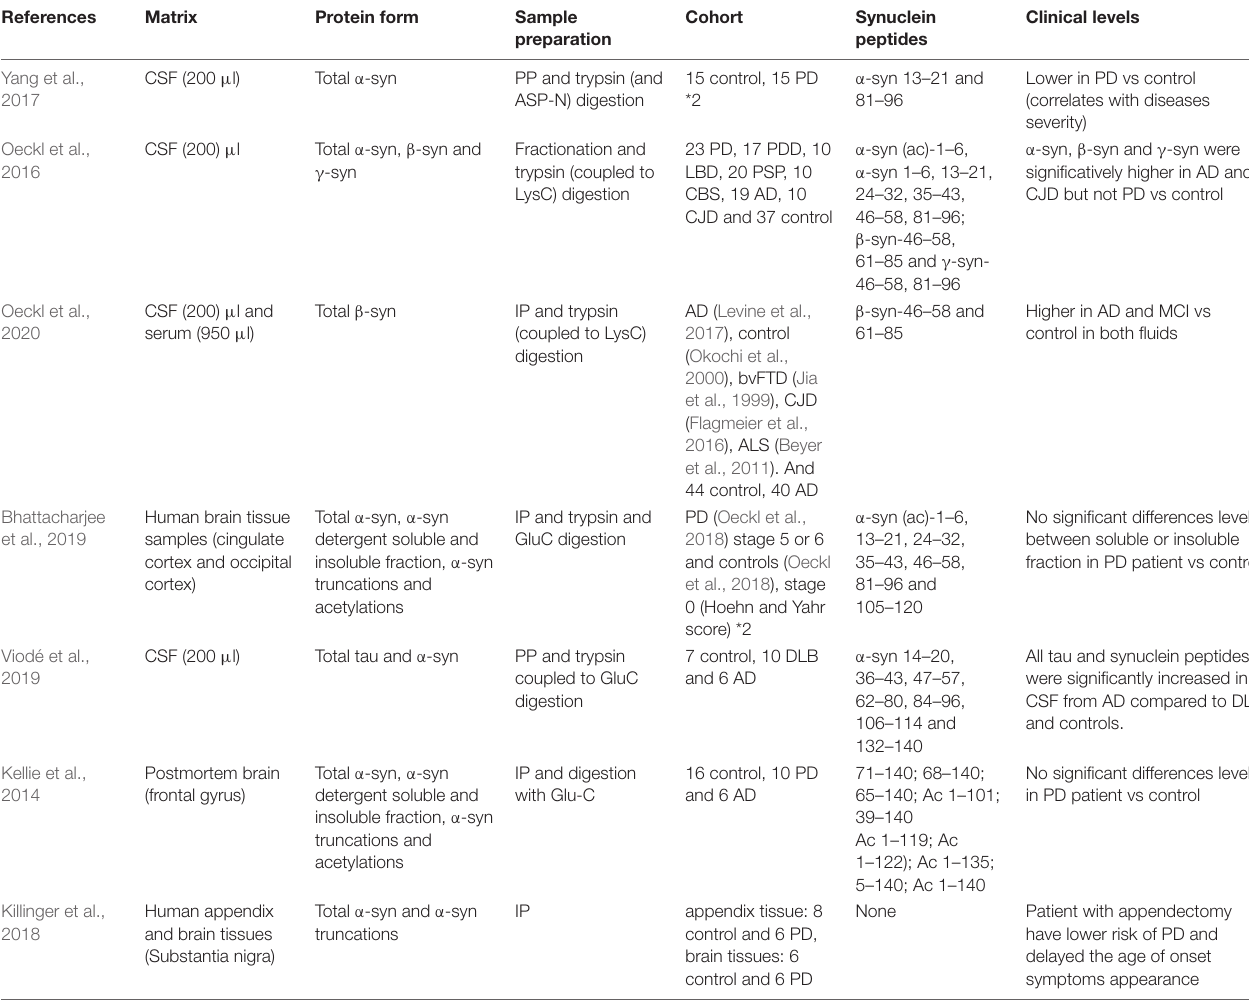
TABLE 4 | Summary table of synuclein studies by mass